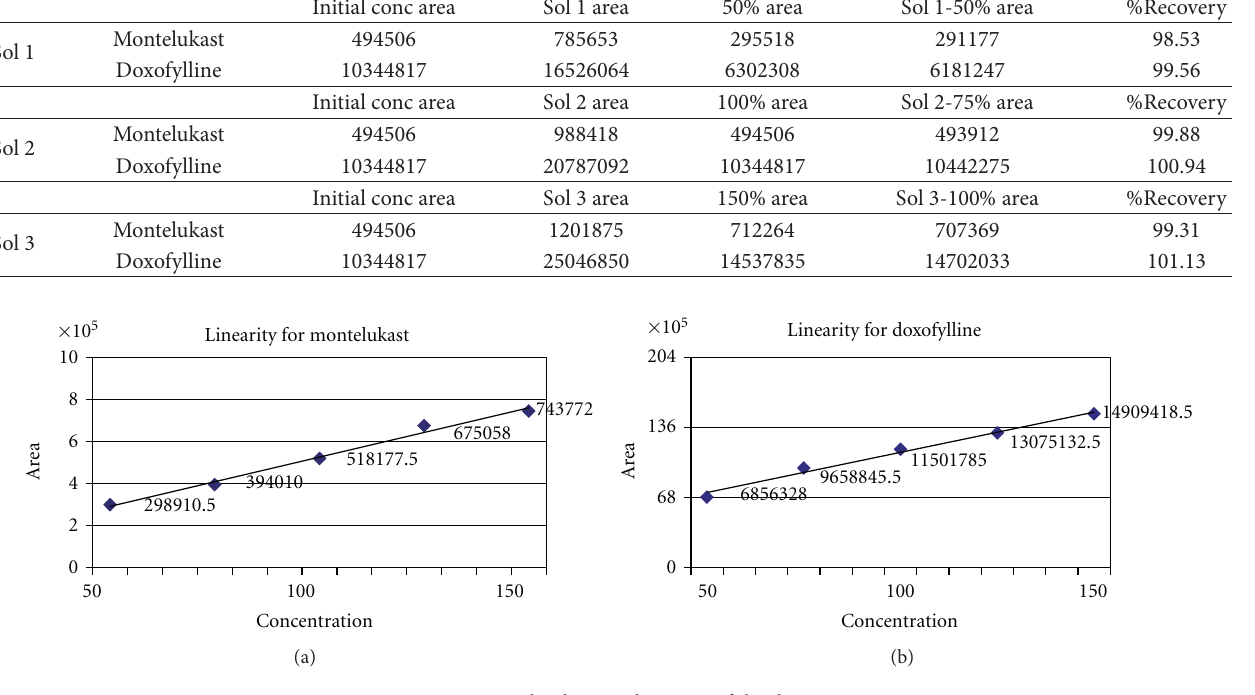
F 6: Graphs showing linearity of the